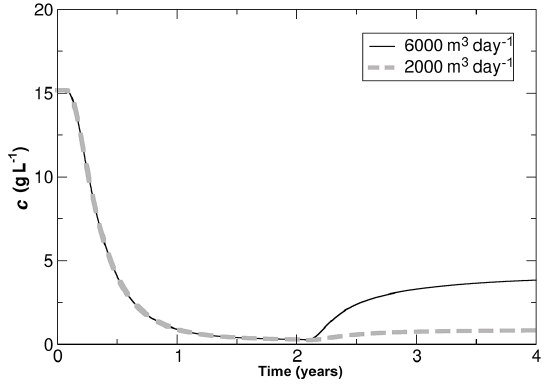
Figure 15. The salt concentration versus time at the pumping well intake for the two selected values of Q withdrawn